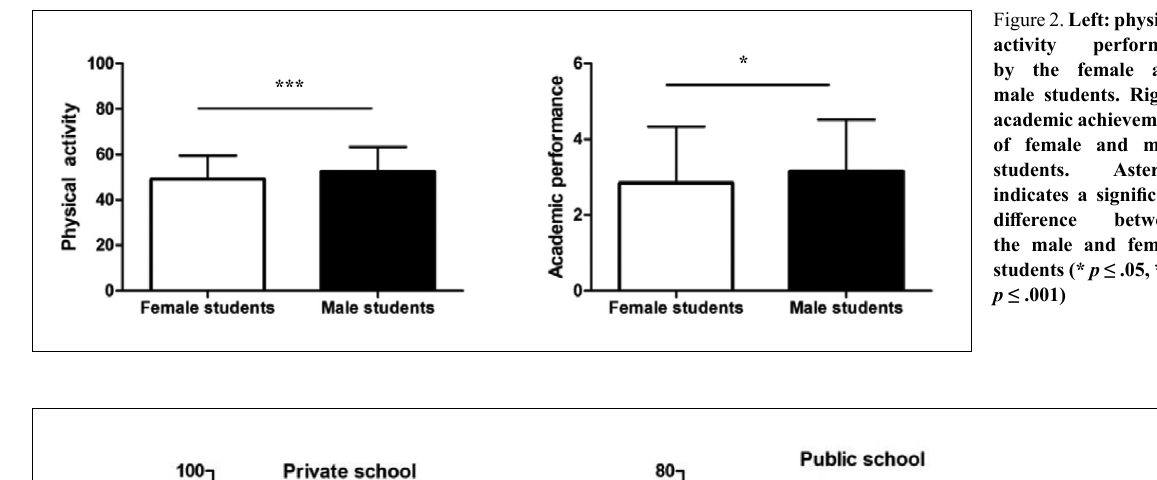
Figure 2. Left: physical activity performed by the female and male students. Right: academic achievement of female and male students. Asterisk indicates a significant difference between the male and female